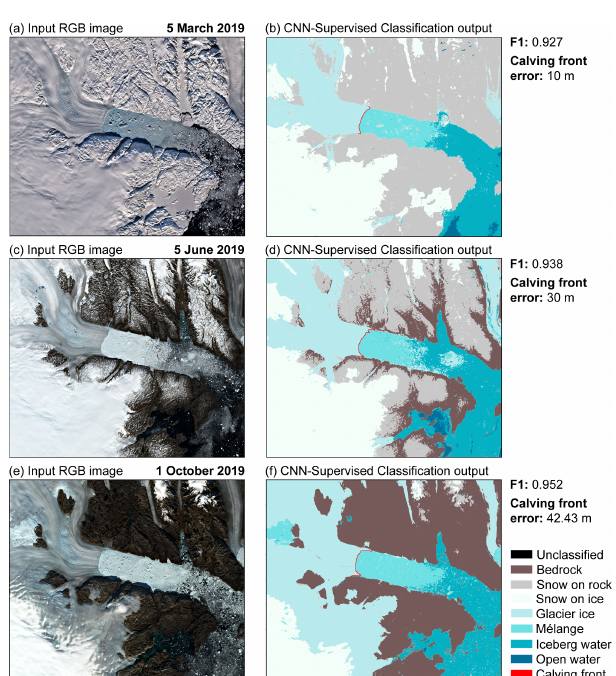
Figure 8. Examples of pixel-level classification outputs for season- ally variable imagery from the in-sample test site showing input images of Helheim in the first column, which were acquired on (a) 5 March 2019, (c) 5 June 2019, and (e) 1 October 2019 and the as- sociated CSC outputs shown in (b) , (d) , and (f) . Classifications pro- duced using optimal parameters with F 1 scores and calving front er- ror shown next to each classification. All Sentinel-2 imagery in this figure is courtesy of the European Union Copernicus